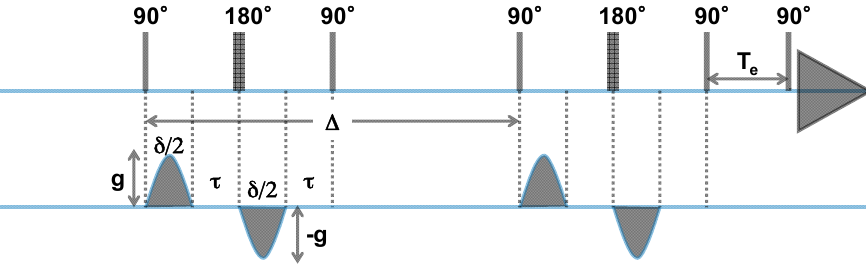
Figure 2. The pulse sequence BiPolar-Pulse Field Gradient-STimulated Echo-Longitudinal Eddy current Delay (BP-PFG-STE-LED) used for DOSY experiments: δ /2 = length of the diffusion gradient, τ = gradient recovery delay, g = gradient strength, T e = length of the eddy current delay, Δ = the Stejskal–Tanner diffusion delay.